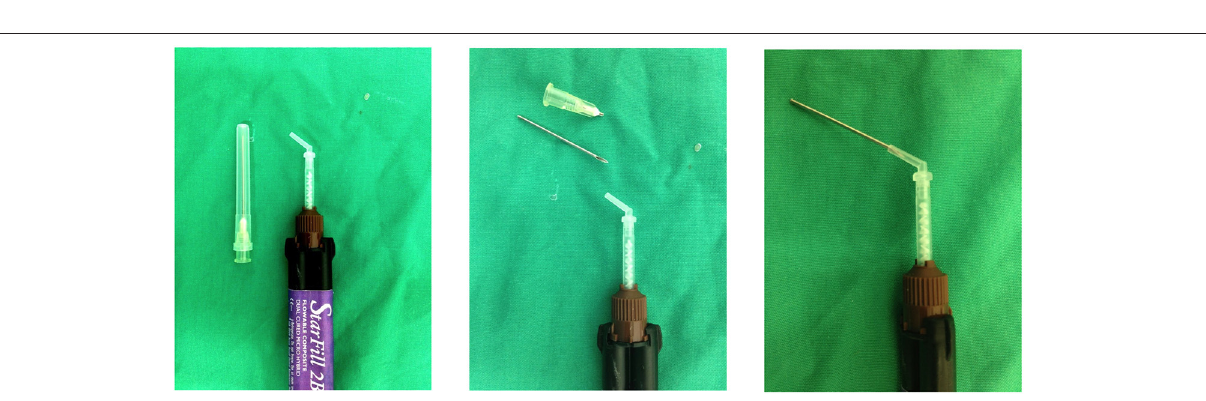
FIGURE 3 | Method used to fabricate mixing tip extensions using a 19G 3.8cm hypodermic